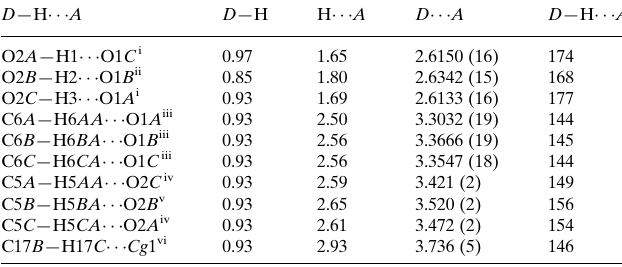
Hydrogen-bond geometry (A˚ , (cid:2)